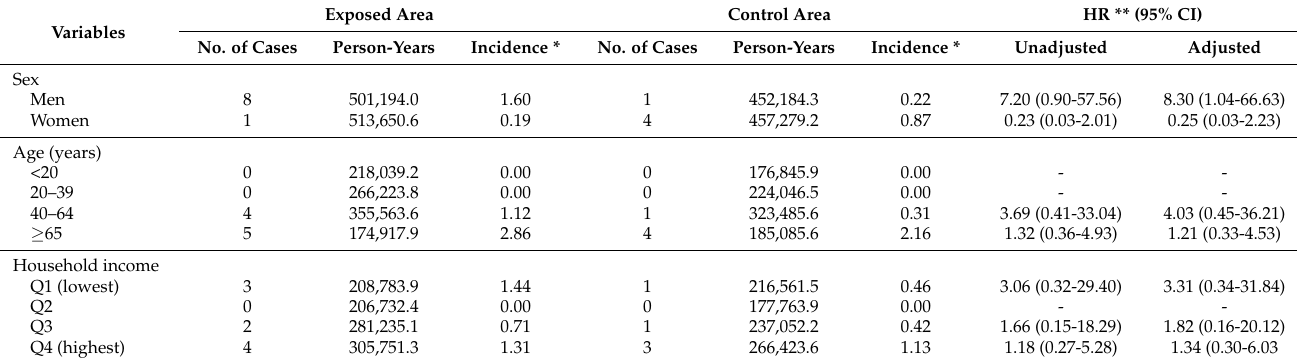
Table 3. Incidence rates and hazard ratios of mesothelioma stratified by sex, age, and household